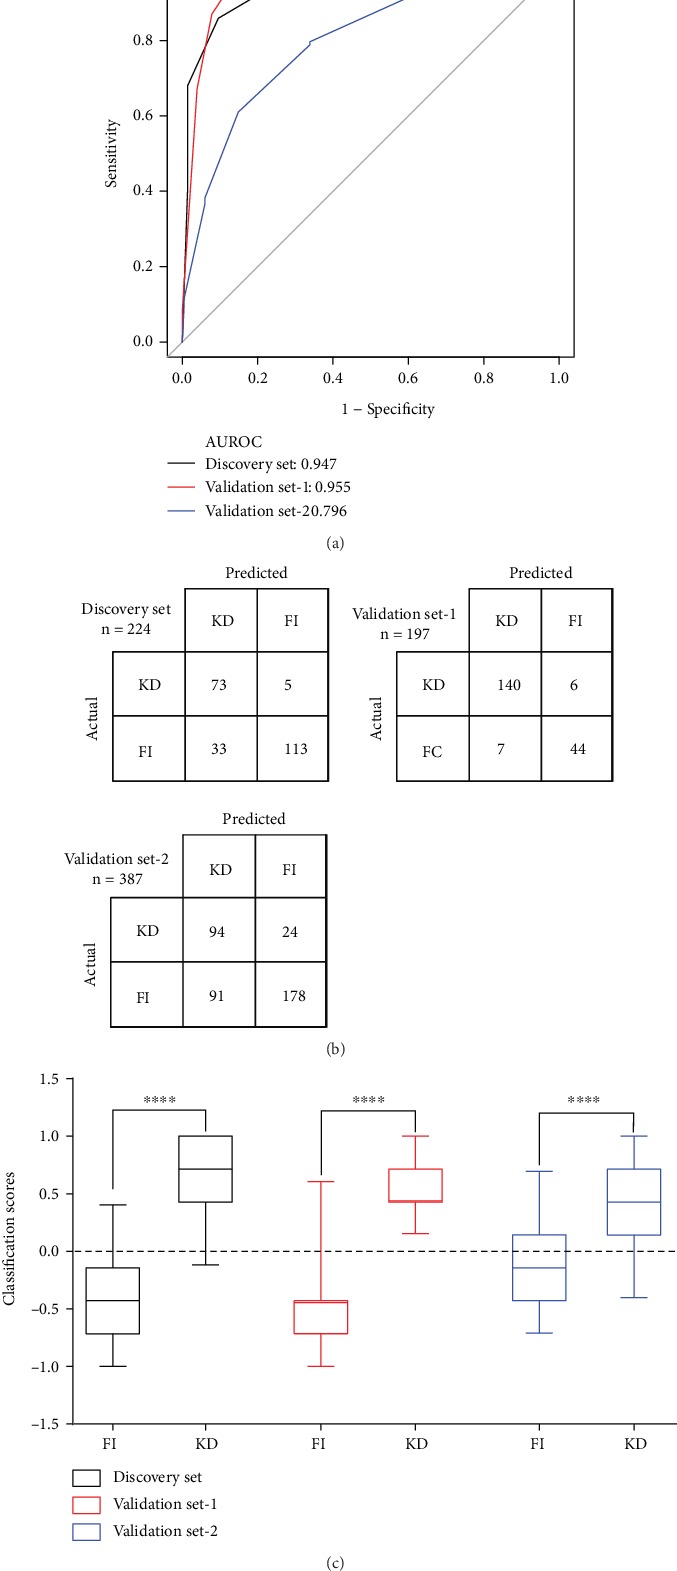
Prediction performance of the TRGP classifier using the seven top-ranked gene pairs. (a) The ROC curve, (b) the prediction confusion matrix, and (c) the classification scores of FI and KD patients in the discovery set (black), validation set-1 (red), and external validation set-2 (blue). In box plots (c), the horizontal lines, box edges, and whiskers represent the median, interquartile ranges, and 95% percentile range, respectively. The dotted line represents the threshold of classification, and the classification scores > 0 are predicted to be KD, otherwise FI. AUROC: area under the receiver-operating characteristic curve. A two-tailed unpaired Student's t-test was used for statistical comparison of classification scores between FI and KD patients. ∗P < 0.05,∗∗P < 0.01,∗∗∗P < 0.001, and∗∗∗∗P < 0.0001.